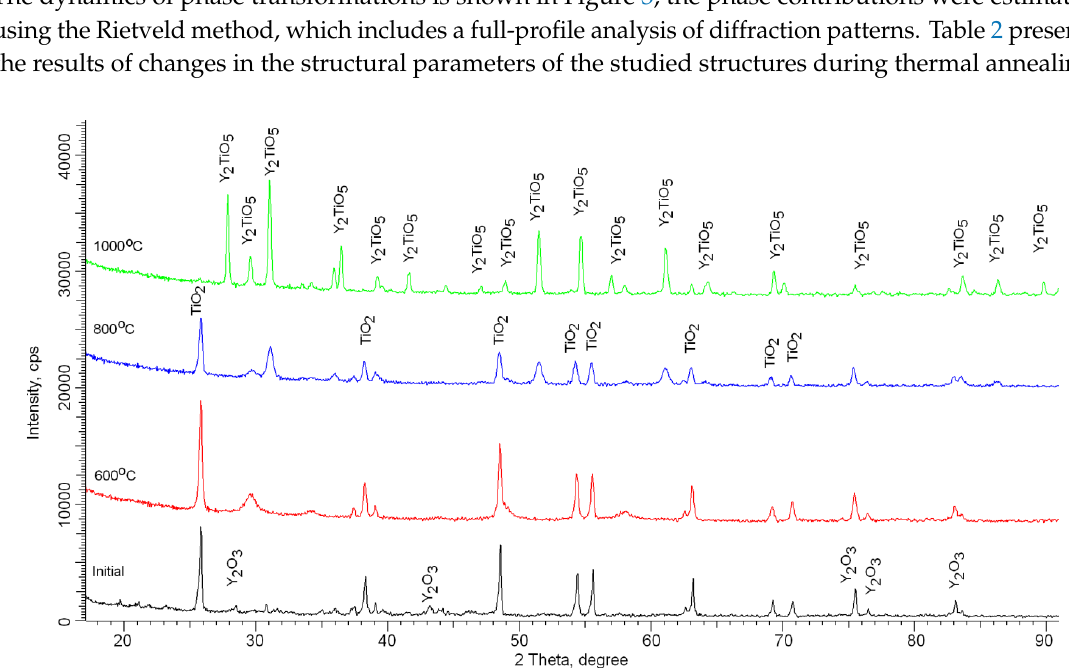
Table 1. Elemental analysis of nanostructures Y 2 O 3 /TiO 2 -Y 2 TiO 5 doped CNTs